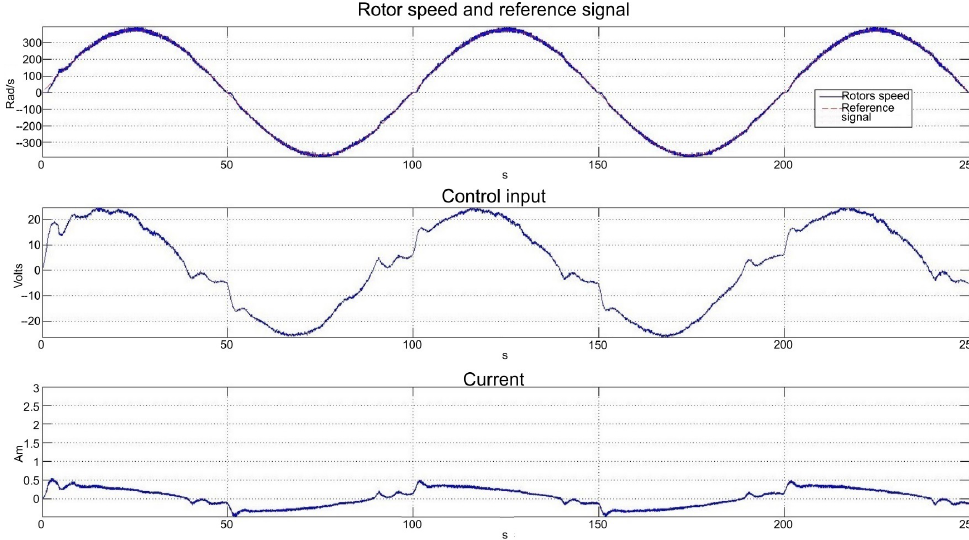
Figure 22. Responses to sinusoidal reference R ( t ) = 380sin ( 0.063 t ) .